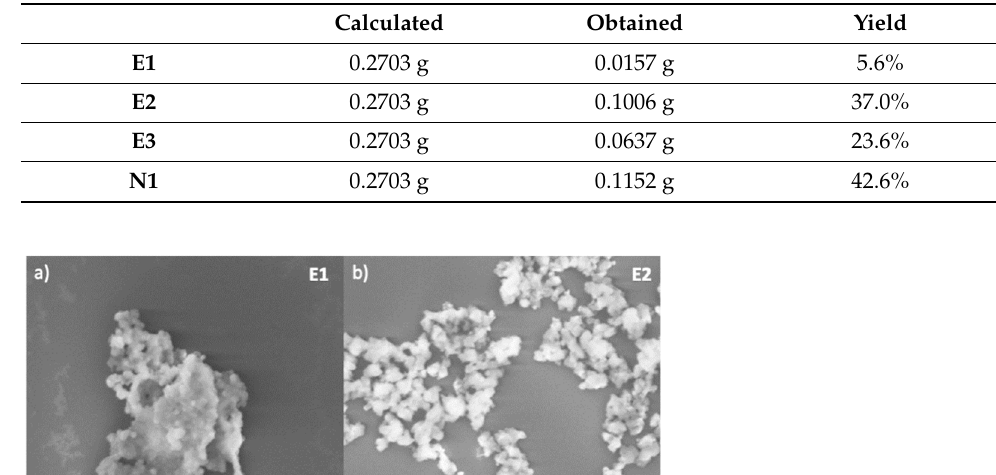
Table 1. Obtained yields for the different synthetic procedures.